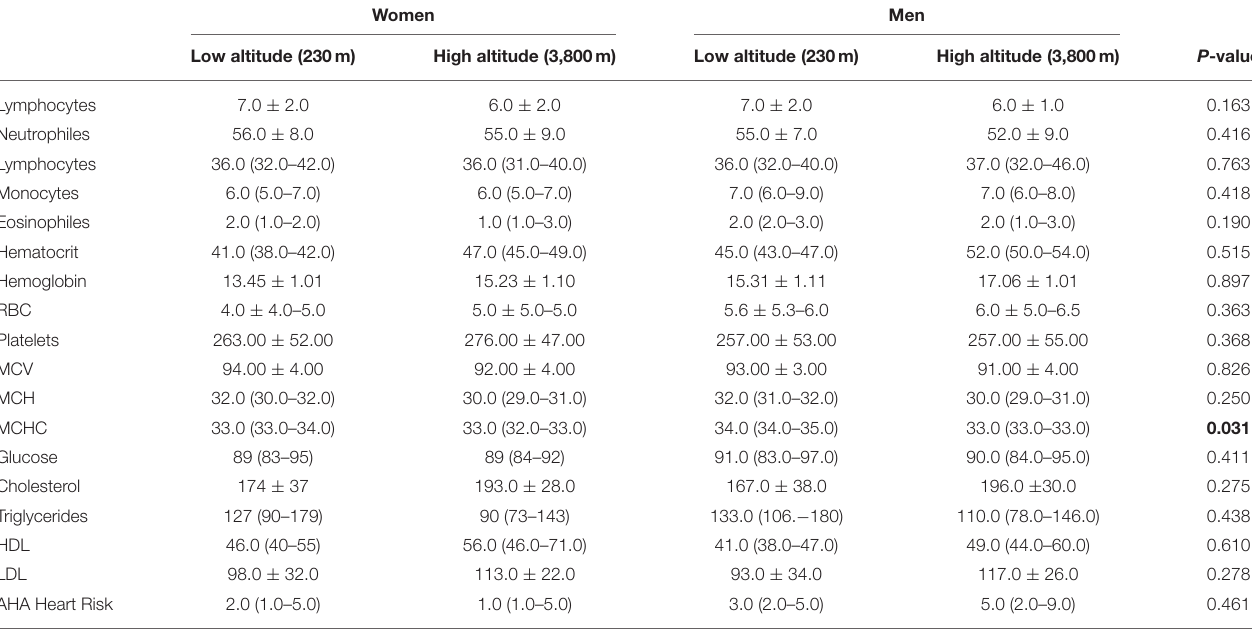
TABLE 3 | Complete blood count (CBC) and blood biochemical analysis in low and high-altitude dwellers.